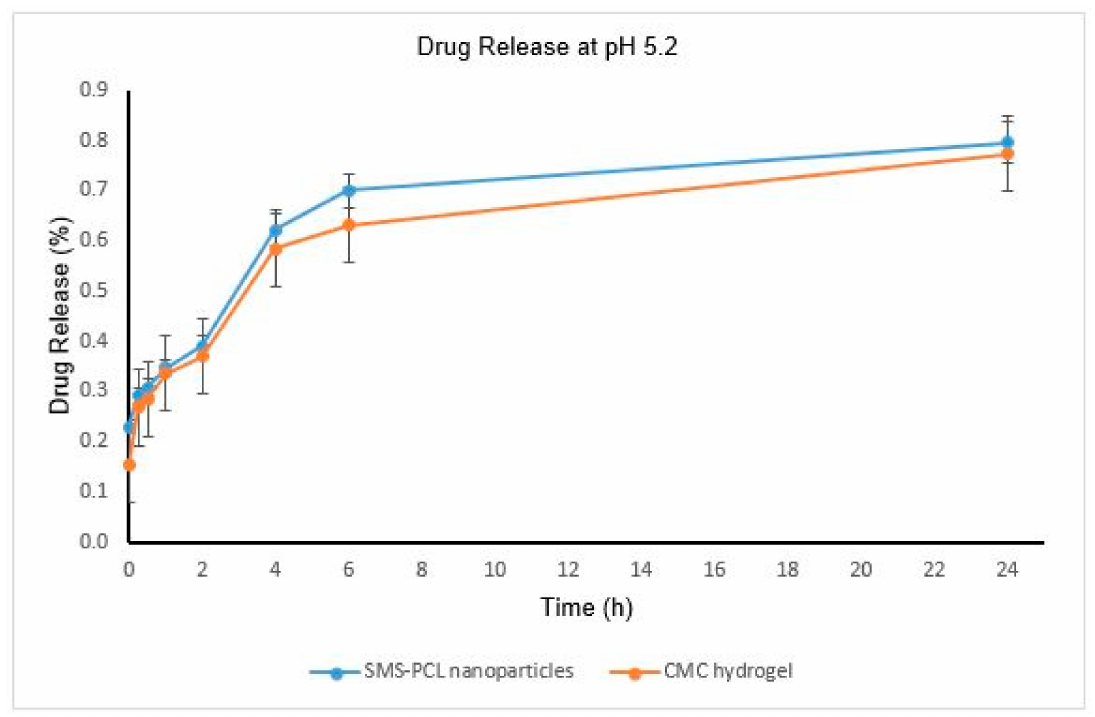
Figure 7. HCT release profiles from SMS-PCL nanoparticles and CMC hydrogel, at simulated PV skin pH (pH 5.2) at 37 ◦ C over a period of 24 h.